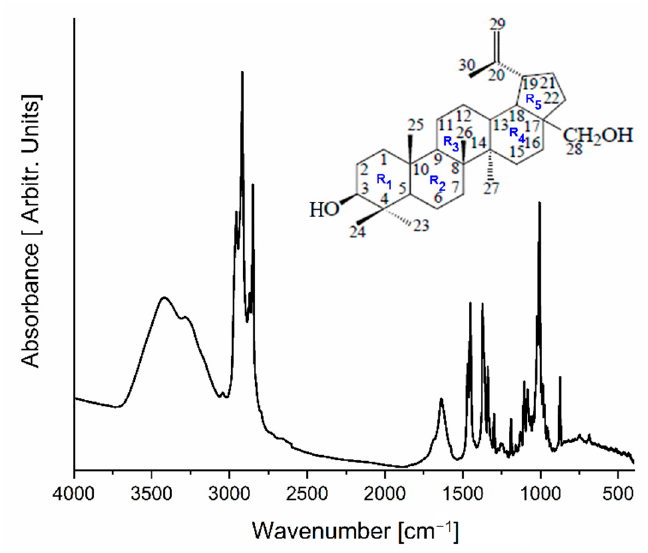
Figure 1. The FT-IR spectrum of a solid product isolated from the Piptoporus betulinus extract.